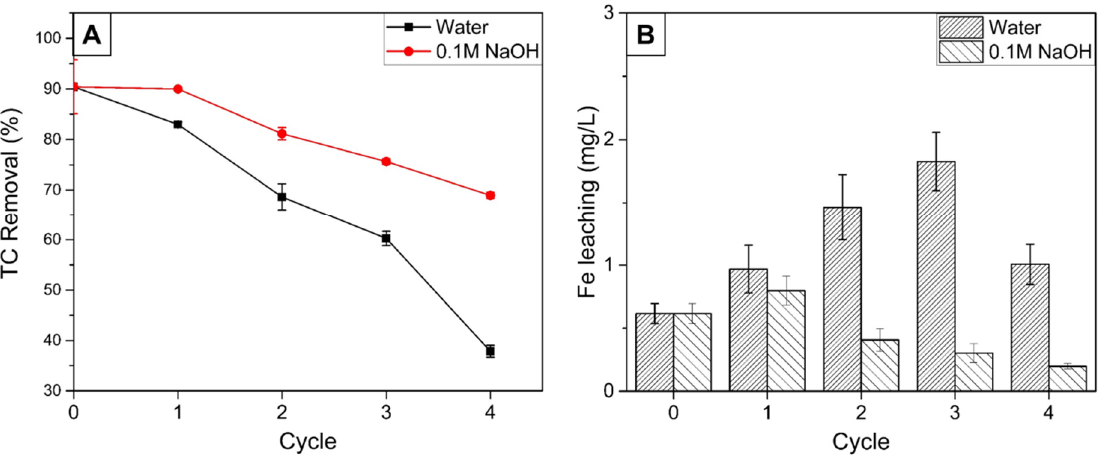
Figure 7. ( A ) The recycled experiments with different eluting agents; ( B ) the iron leaching after the degradation experiments for each cycle (conditions: C 0 = 800 mg/L, pH 3.2 (natural), H 2 O 2 concen- ◦ tration = 5 mM, catalyst concentration = 1 g/L, T = 28 ± 2 °C). concentration = 5 mM, catalyst concentration = 1 g/L, T = 28 ± 2